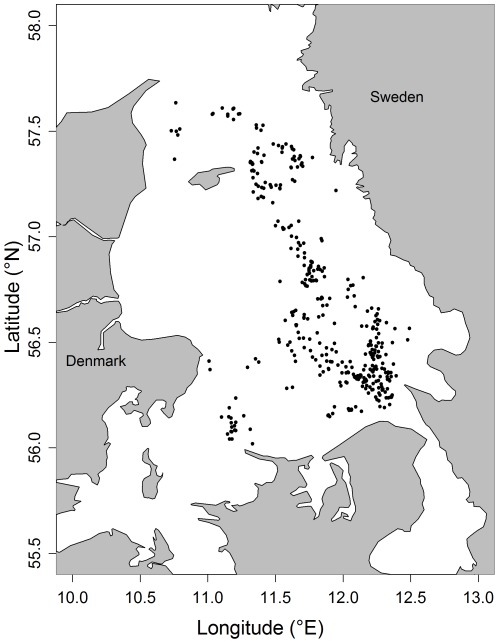
Map of the study area with the location of discards observer hauls used in the analysis.Locations represent the mid-way point of each haul.